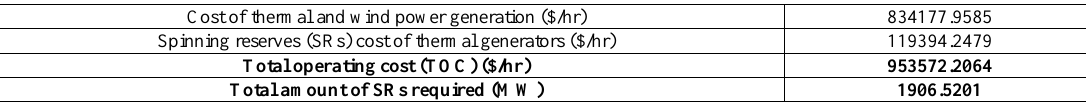
Table 1. Objective function values for Case Study